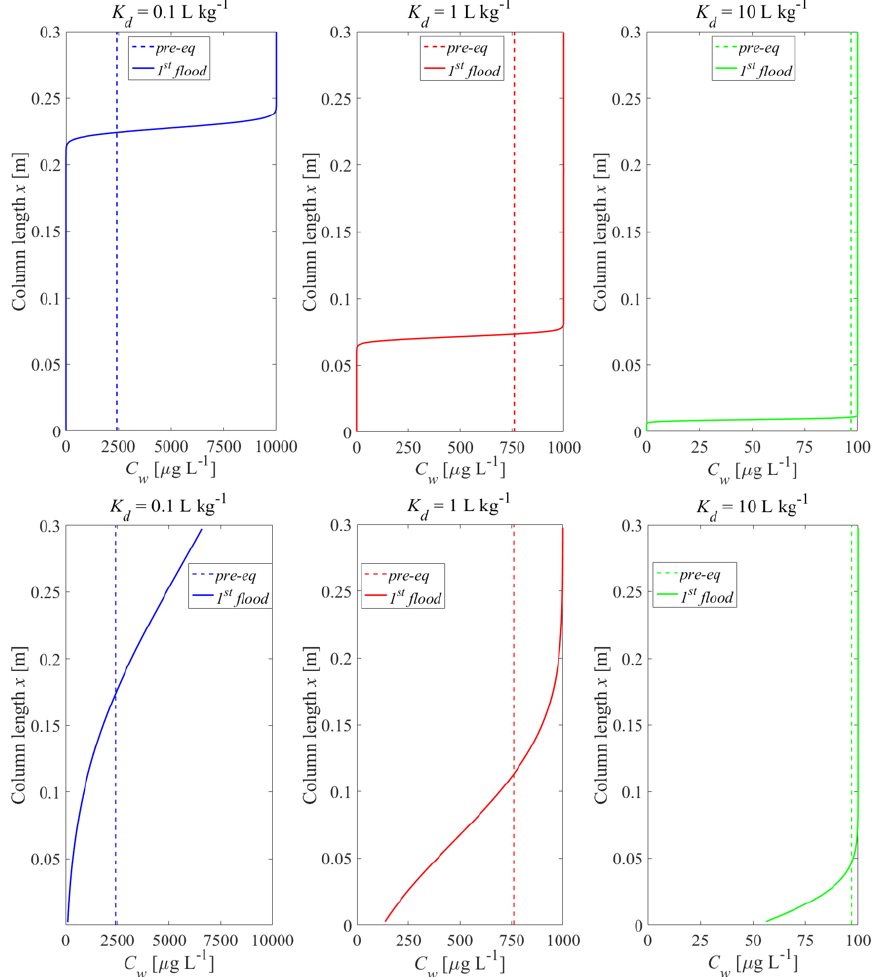
Figure 4. Initial aqueous concentration distributions in the column after the first flooding (solid lines) if mass transfer is controlled by film diffusion for three different distribution coefficients, K d , compared to the pre-equilibrated case (dashed lines). Top panel : without dispersion; bottom panel : with dispersion; n = 0.45, v = 1.67 × 10 − 5 m s − 1 , α / x = 0 or 0.1, C s , ini = 1000 µ g kg − 1 , t c = 5 h, d p , fine = 63 µ